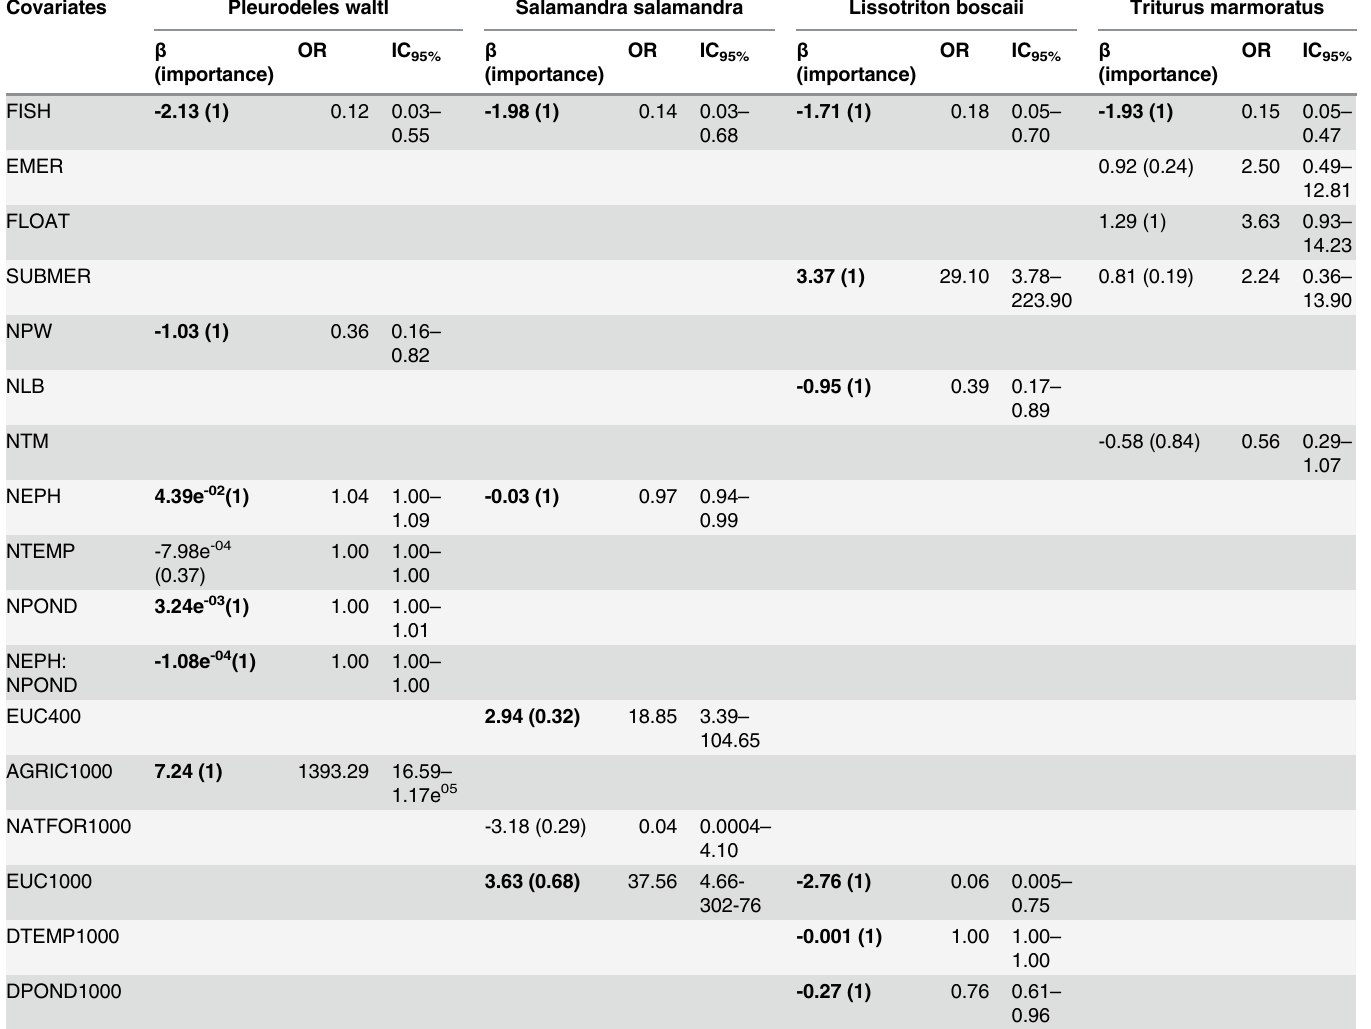
Table 2. Model averaged parameter estimates ( β ) (top-ranked models) for each of the Caudata, odds ratio (OR) and respective 95% confidence in- tervals (IC 95%